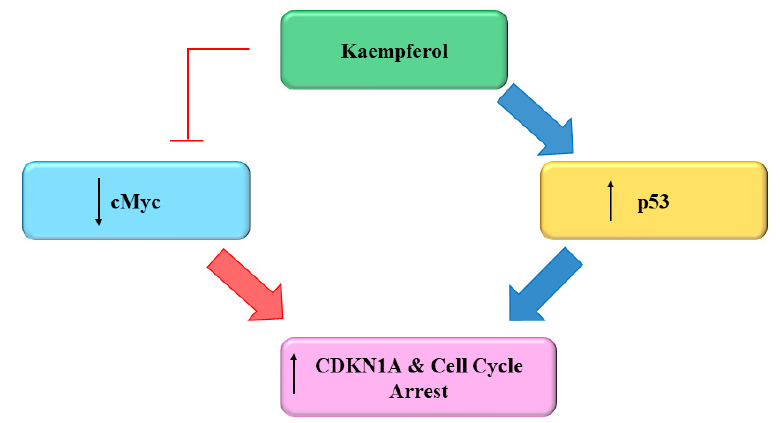
Figure 5. Effect of Kaempferol on the Cell Cycle [112].